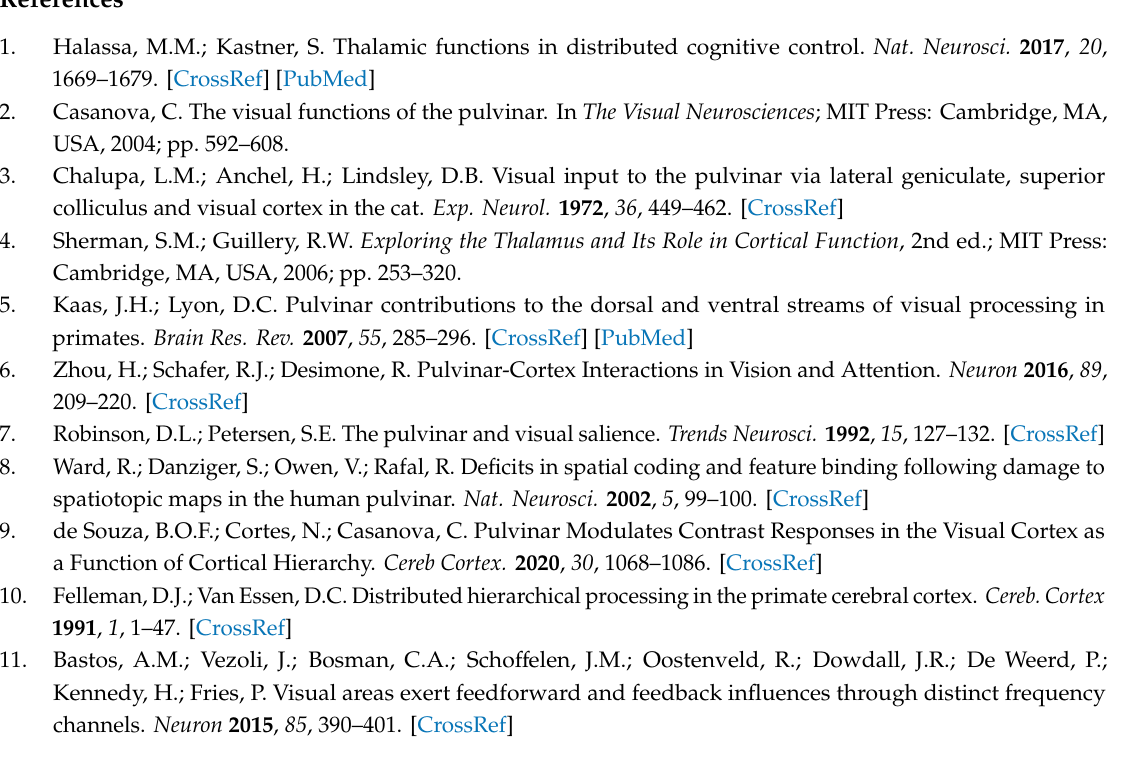
Figure S1: Validation of GABA injection in LP nucleus, Figure S2: Influence of MUA activity on the oscillatory cortical responses of areas 17 and 21a across cortical layers, Figure S3: The coupling index was calculated for the functional feedback connection between layer VI of area 21a and layer II / III of area 17, Table S1: E ff ect of LPl inactivation on the MUA of areas 17 and 21a, Table S2: Correlation between MUA activity on the oscillatory cortical responses of areas 17 and 21a across cortical layers, Table S3: E ff ect of LPl inactivation on alpha- and gamma waves of areas 17 and 21a, Table S4: The oscillatory activity (db from baseline / s) and %Var(Ctr) for alpha- and gamma waves of areas 17 and 21a across conditions, Table S5: E ff ect of LPl inactivation on alpha- and gamma waves across layers of areas 17 and 21a, Table S6: The oscillatory activity (db from baseline / s) and %Var(Ctr) for alpha- and gamma waves of areas 17 and 21a across cortical